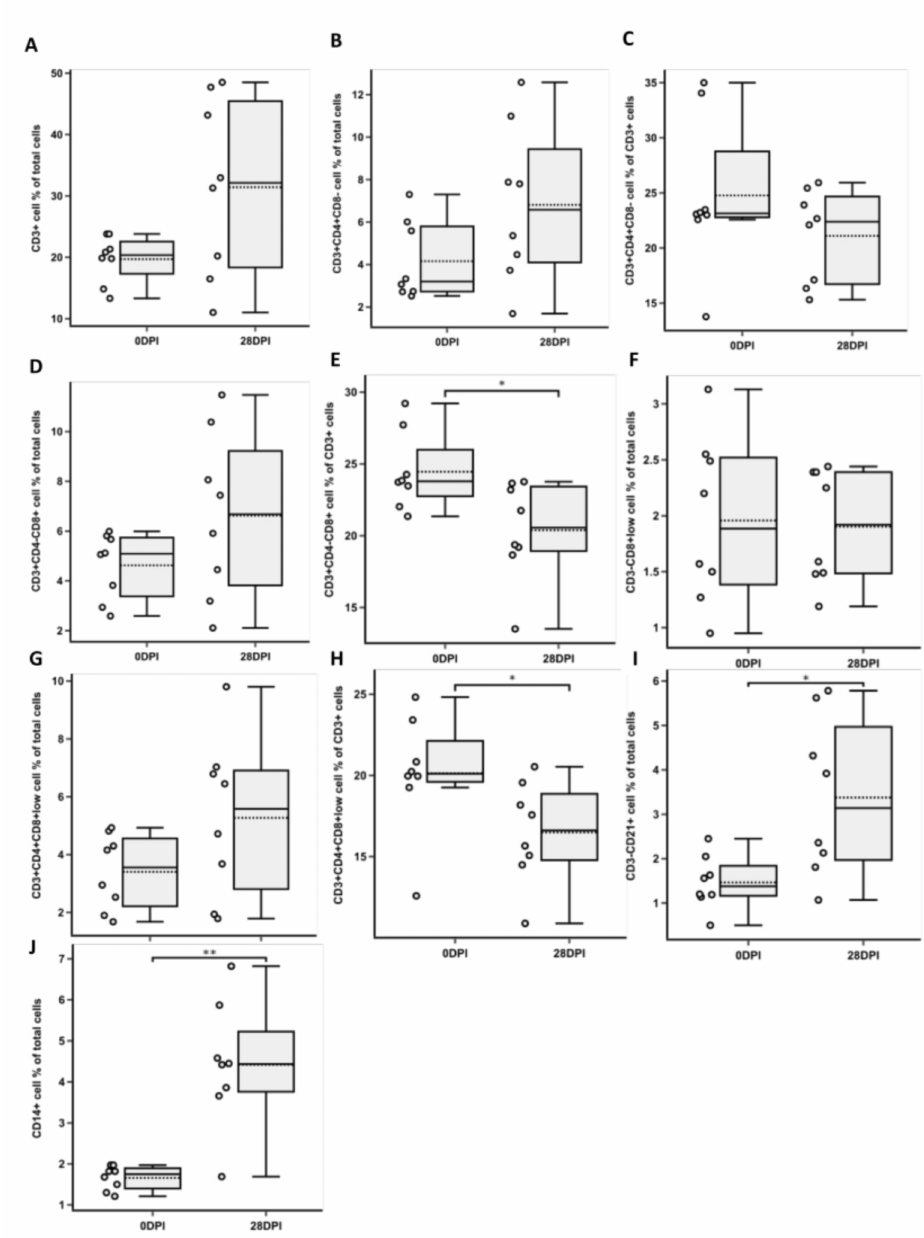
Figure 2. Immunophenotyping of cells obtained from pigs before (0DPI) and 28 days after (28DPI) supplementary feeding by flow cytometry. Box plots show the percentage (mean ± SD) of CD3 + cells ( A ), T helper cell (CD3 + CD4 + CD8 − ) proportion of total ( B ) and CD3+ ( C ) cells, T cyto- toxic cell (CD3 + CD4 − CD8 + ) proportion of total ( D ) and CD3 + ( E ) cells, percentage of NK cells (CD3 − CD4 − CD8 +low ) ( F ), T memory cell (CD3 + CD4 + CD8 +low ) proportion of total ( G ) and CD3 + ( H ) cells, percentage of B cells (CD3 − CD21 + ) ( I ), and percentage of macrophage/monocyte cells (CD14 + ) ( J ). Asterisks indicate statistical significance between groups based on two-tailed Wilcoxon rank sum test results (* p < 0.05; ** p <